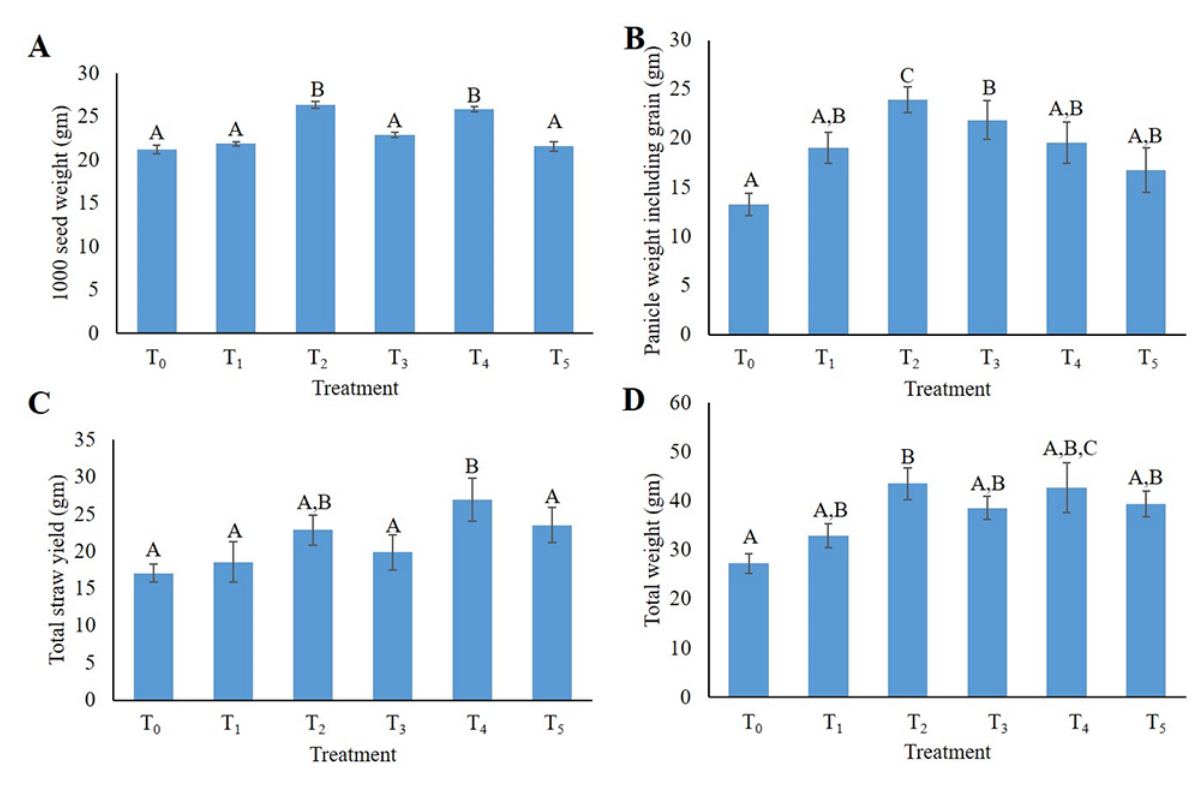
Figure 4 Total 1,000-seed weight (g) ( A ), panicle weight including grains (g) ( B ), total straw yield (g) ( C ), and total weight of straw, panicle, and grain (g) ( D ) for the rice ‘Swarna,’ influenced by boron in saline conditions. T0: Saline condition of EC 9.0 dS/m + no additional boron applied; T1: No saline condition + no additional boron applied; T2: saline condition of EC 9.0 dS/m + boron application as solubor at a rate of 4.5 kg B ha − 1 ; T3: Saline condition of EC 9.0 dS/m + boron application as solubor at a rate of 5.9 kg B ha − 1 ; T4: saline condition of EC 9.0 dS/m + boron application as solubor at a rate of 7.5 kg B ha − 1 ; T5: saline condition of EC 9.0 dS/m + boron application as solubor at a rate of 10 kg B ha − 1 . Data are the means of four replicates ± SEM , while ( A ) shows the mean of three replicates ± SEM . All data were analyzed by one-way analysis of variance. Tukey’s test was used to identify the differences between treatments. Values with different superscript characters (A, B, C) are significantly different ( p < 0.05).